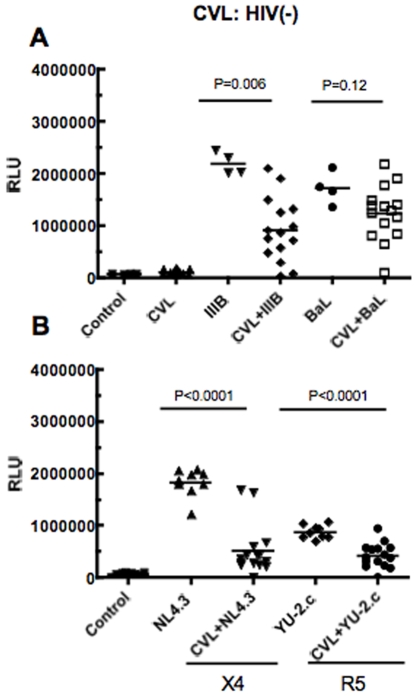
Analysis of antiviral activity in CVL from HIV(−) women.Fifteen HIV(−) CVL were diluted 1∶4 and incubated with HIV-1 IIIB (X4-tropic) and BaL (R5-tropic) (Panel A) or NL4.3 (X4) and YU-2.c (R5) (Panel B) at MOI 1 for 1h at 37°C prior to infecting TZM-bl cells. Media only “Control” and virus only (IIIB, BaL, NL4.3 and YU-2.c) wells were set up as positive controls. Each data point in graph represents one individual patient. Data points in each graph represents one individual patient. Significant differences between control (virus alone) and virus+CVL are indicated in Figure.